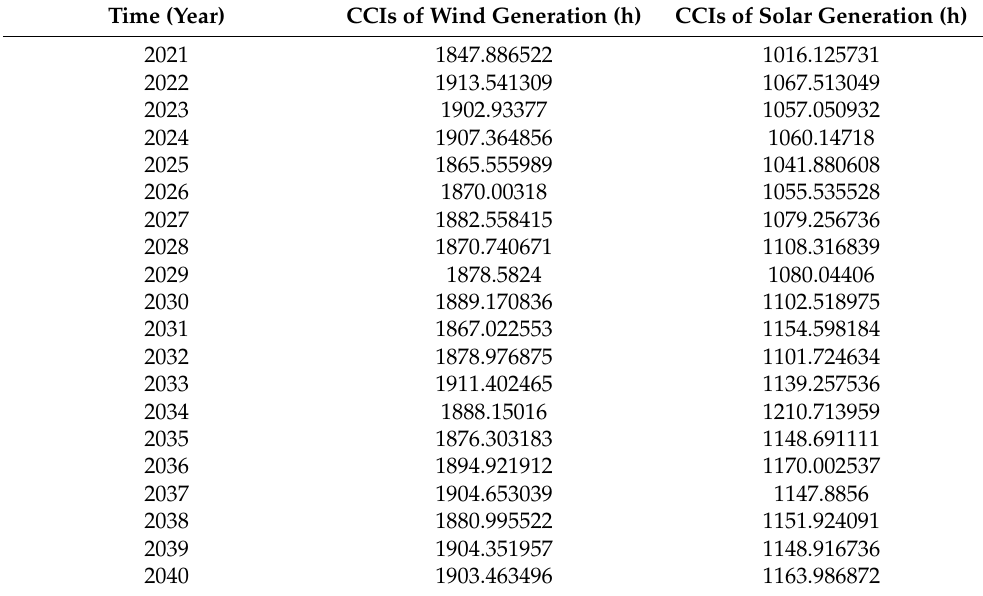
Table 2. The predicted CCIs of wind and solar power.